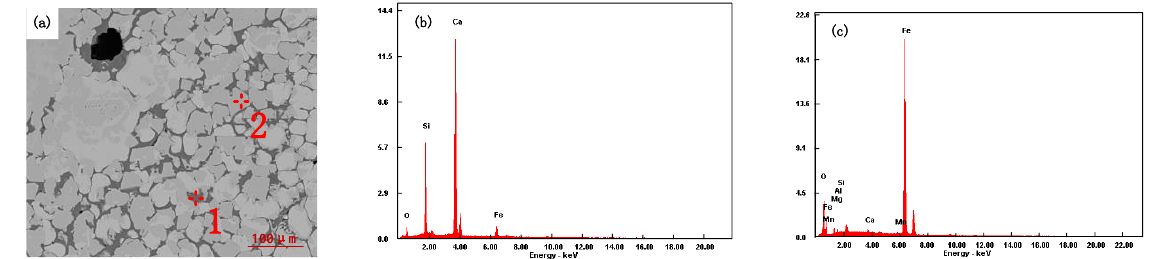
Figure 12. A1 SEM and EDS diagram of sinter: ( a ) A1 sintering ore, ( b ) 1, ( c ) 2.